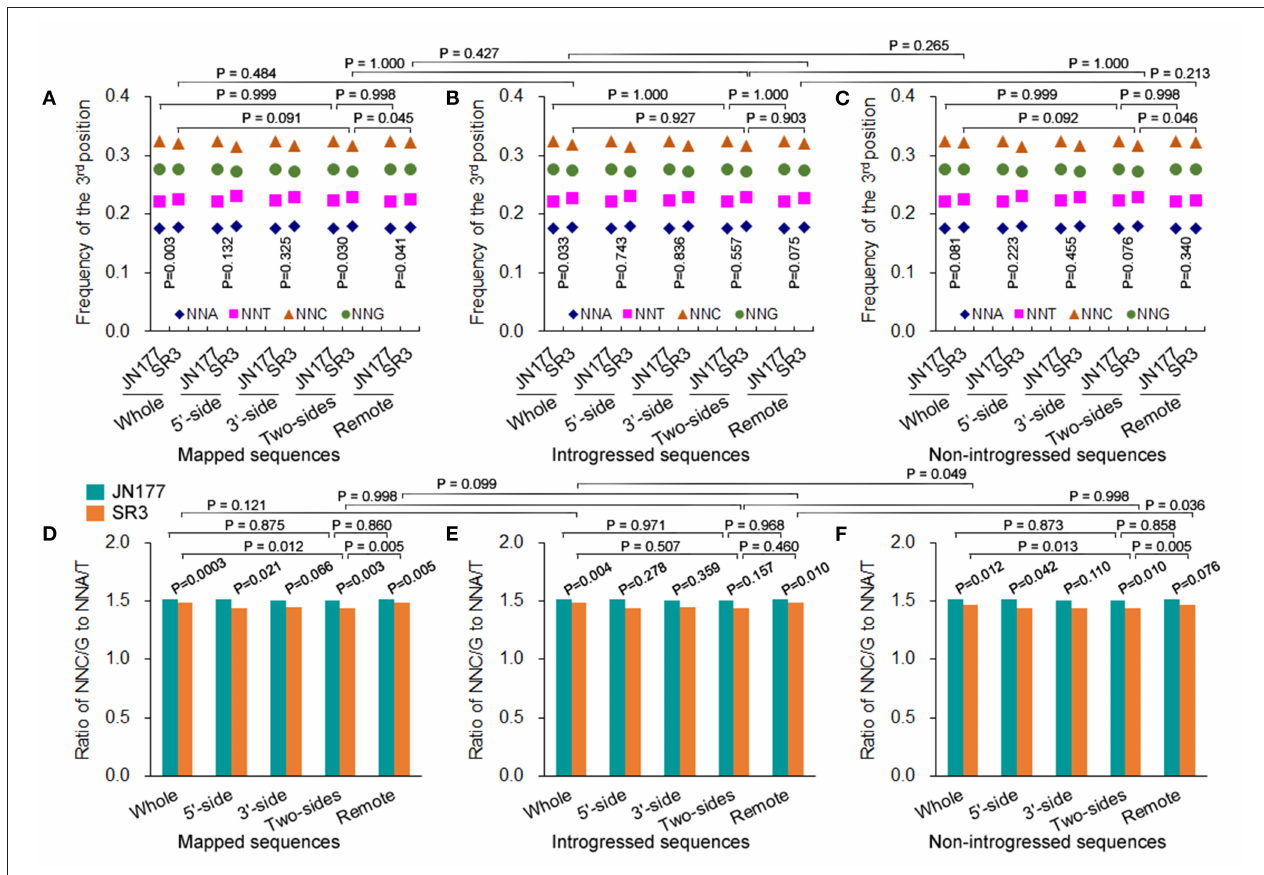
FIGURE 3 | SCUB shift was promoted close to indels. (A–C) The total frequencies of NNA, NNT, NNC, and NNG codons in indel-flanking and non-flanking sequences. (D–F) The ratio of NNC and NNG frequency to NNA and NNT frequency. Whole: the whole part of sequences; 5 ′ -side: 5 ′ -side sequences flanking to indels; 3 ′ -side: 3 ′ -side sequences flanking to indels; Two-sides: 5 ′ - and 3 ′ -side sequences flanking to indels; Remote: the sequences non-flanking to indels. The statistical comparison was conducted with chi square ( χ 2 ) test of fourfold cross-table